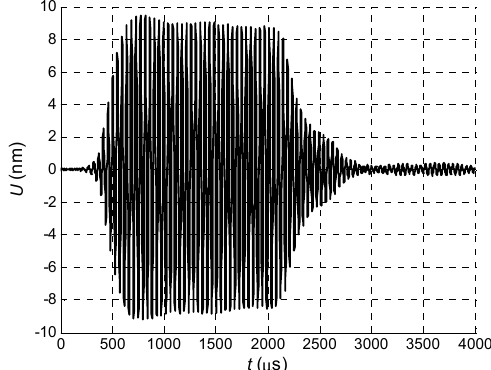
Figure 29. Normal displacement signal U of the clear PVC film, measured at L = 1 mm, when all array elements are excited using optimized delay scheme.